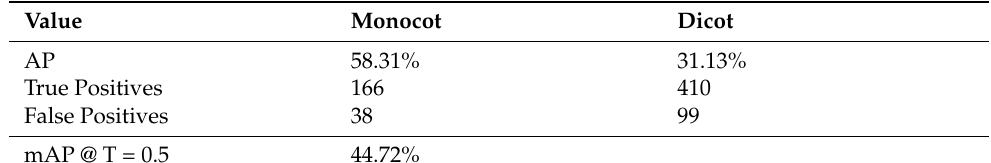
Table 6. Network training results for Training Image Set 4.